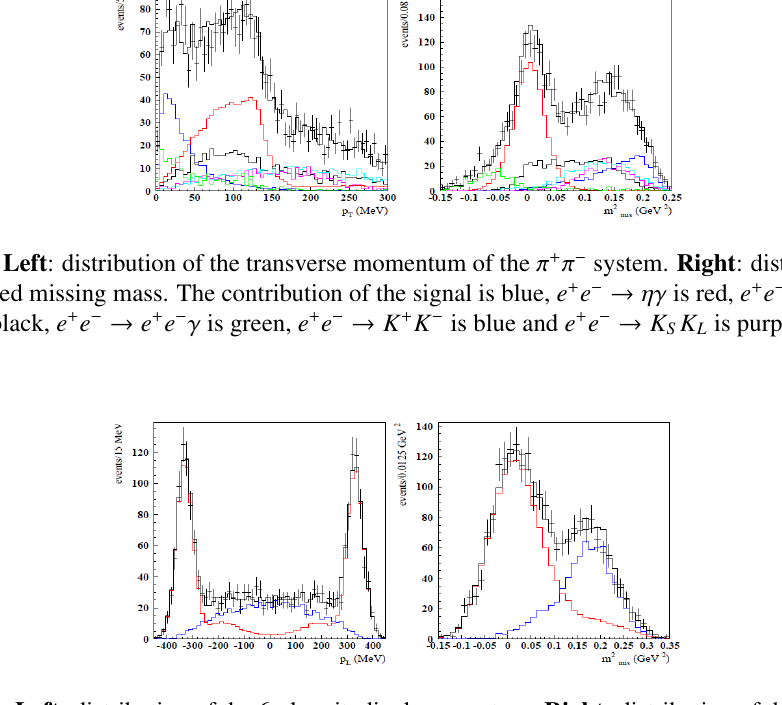
Figure 4: Left : distribution of the 6 γ longitudinal momentum. Right : distribution of the squared missing mass. The blue line corresponds to the signal, the red line to e + e − → ηγ